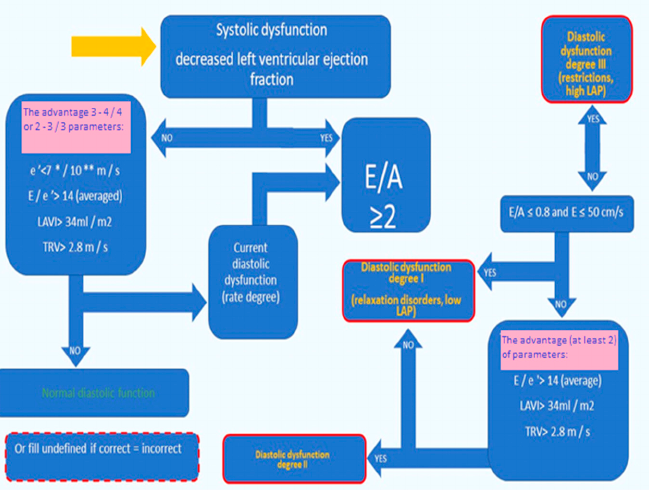
Figure A2. Echocardiographic assessment of left ventricular diastolic dysfunction. E—early mitral inflow velocity; A—late mitral inflow velocity (due to atrial contraction); e’—early diastolic mitral annular velocity; LAVI—left atrial volume indexed to body surface area; TRV—tricuspid valve re- gurgitation maximal velocity’ * septal early diastolic mitral annular velocity; ** lateral early diastolic mitral annular velocity.